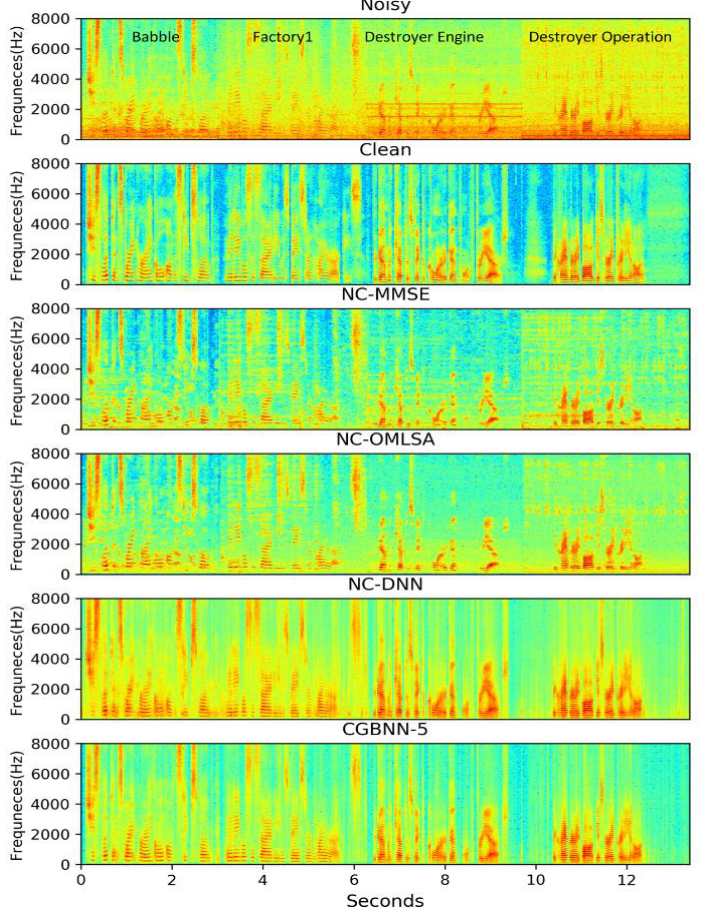
Figure 4. The spectrograms of noisy speech (degraded by four known noises in 0 dB signal-to-noise ratio (SNR) case), clean speech, and enhanced speech using NC-MMSE, NC-OMLSA, NC-DNN, and CGBNN-5. Table 2. Comparison of the normalized model size.